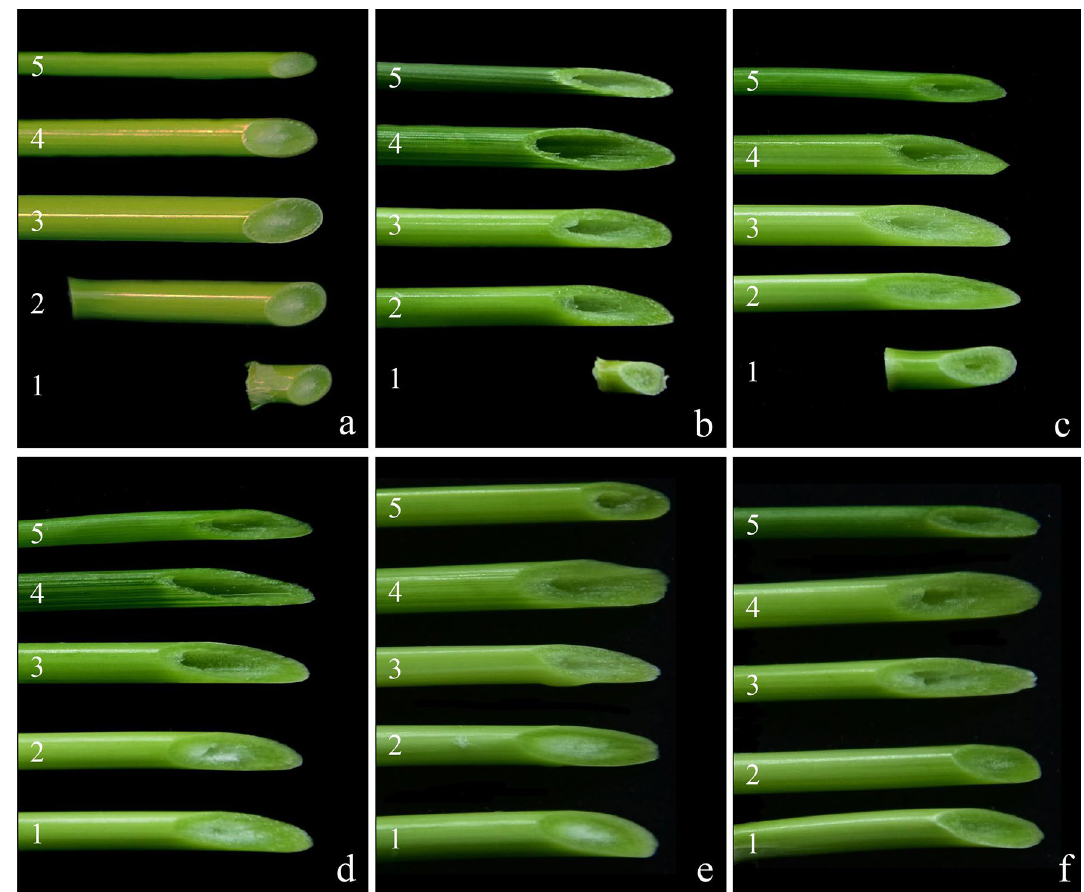
Figure 4. Stalk solidity of synthetic hexaploid wheat grown in the greenhouse. ( a ): Ma; ( b ): CS; ( c ): Syn- SAU-116; ( d ): Syn-SAU-117; ( e ): Syn-SAU-118 and ( f ): Syn-SAU-119. Numbers 1–5 indicate the first to fifth stem internodes (from the base to the top),